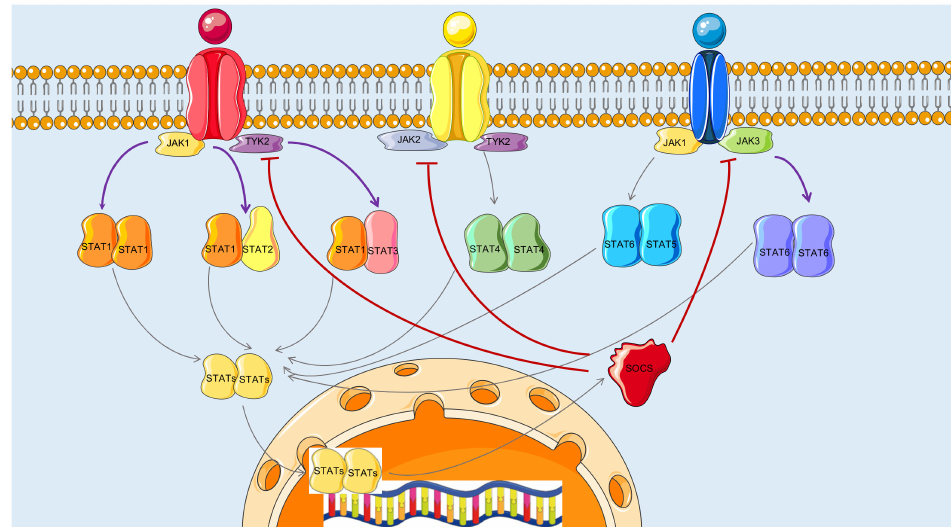
Figure 3. JAK-STAT-SCOS cell model. In canonical JAK-STAT signaling, the binding of extracellular cytokines to their transmembrane receptors results in activation of the pathway in a JAK-mediated manner. Both JAK and cytokine receptors are transphosphorylated by JAKs in close proximity. Activated JAKs phosphorylate STATs, leading to STAT dimerization and eventual translocation into cell nucleus, where they regulate the expression of genes, including SOCS proteins that act as negative feedback inhibitors of JAK-STAT. In BN reconstruction, both BNrich and Ensemble removed all the negative feedback edges representing SOCS inhibition of JAK-STAK (edges in red), while Clipper retained around 1/3 of them. In addition, Clipper also removed some of the JAK-induced STAT phosphorylation (edges in purple). Proteins of the STAT family are present in homodimers or heterodimers. SOCS family can be merged in a single